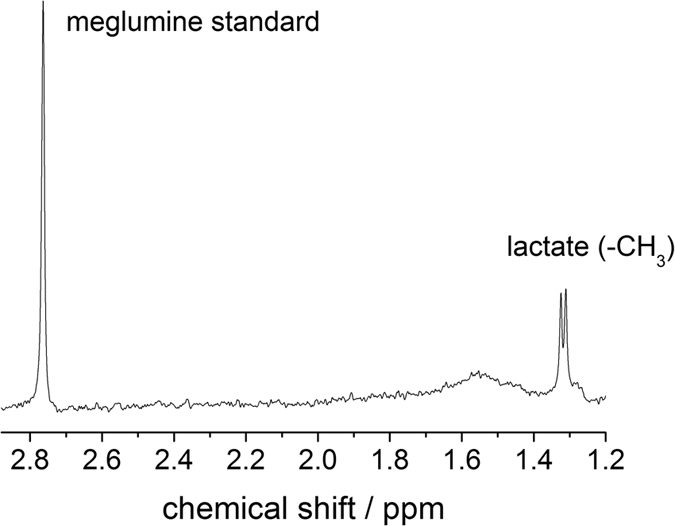
1H spectrum of the in vivo dialysate detected at B0 = 11.7 T.